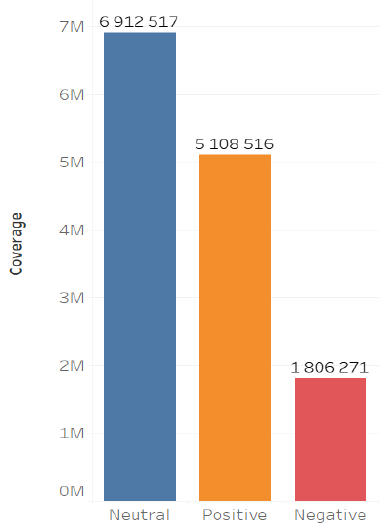
Figure 5. Messages with various sentiment types.